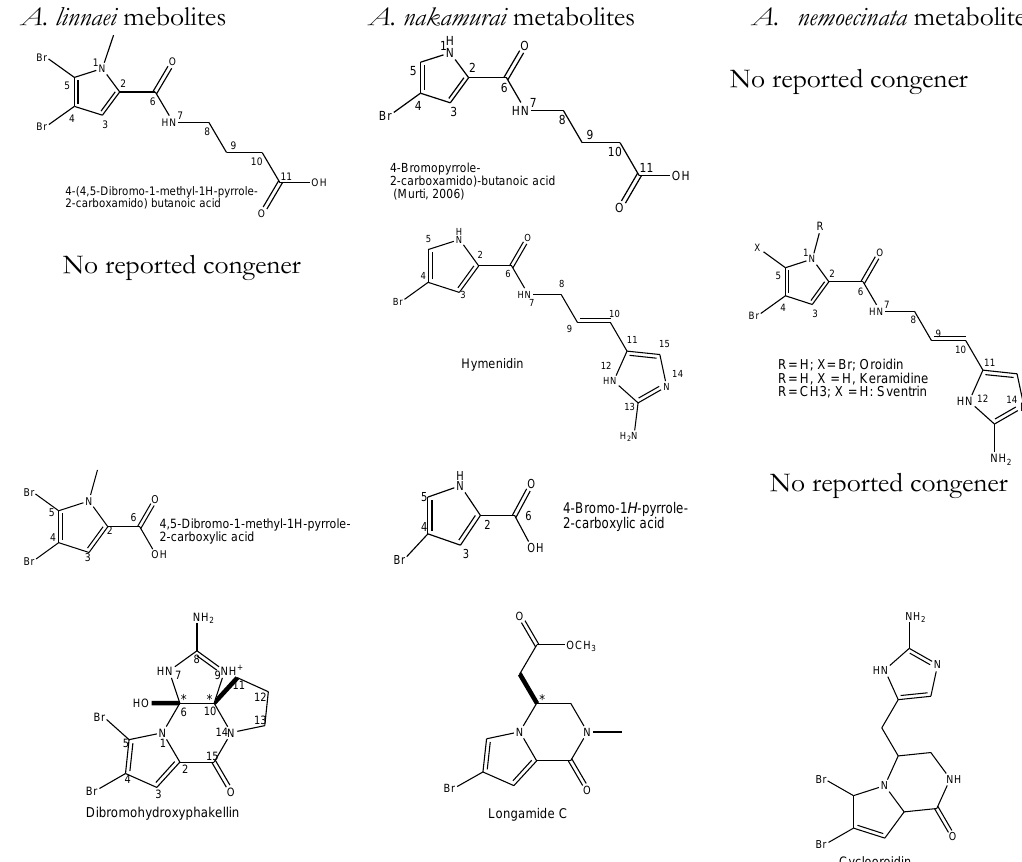
Figure 2. Selected pyrrole-imidazole compounds isolated from A. linnaei (Hertiani et al., 2010) and A. nakamurai (Hertiani et al., 2010; Murti, 2005) and from A. nemoecinata (Pedradab, 2005) showing the similarities and differences in the structure of related compound. * Only relative stereochemistry is